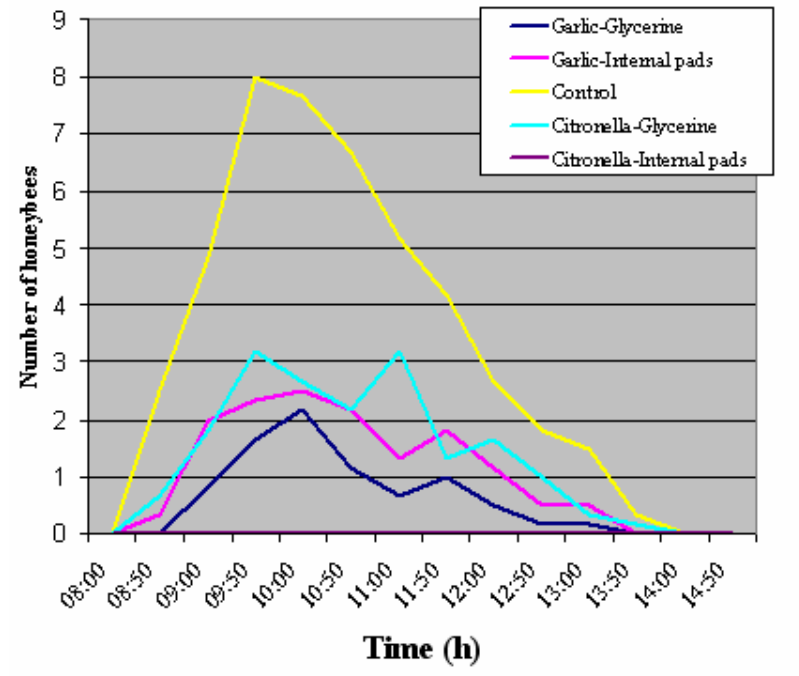
Figure 3 . Average number of foragers in confined beef cattle feeders in